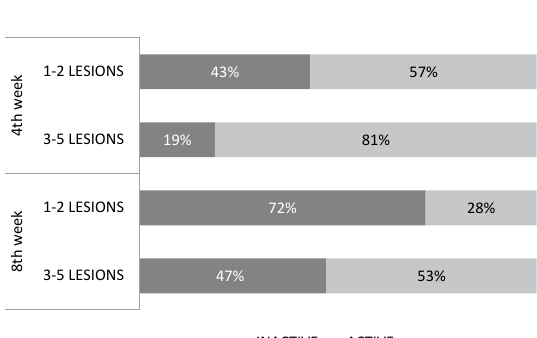
Figure 2 - Distribution of lesions after 4 and 8 weeks by the number of white spot lesions that the patient presented at